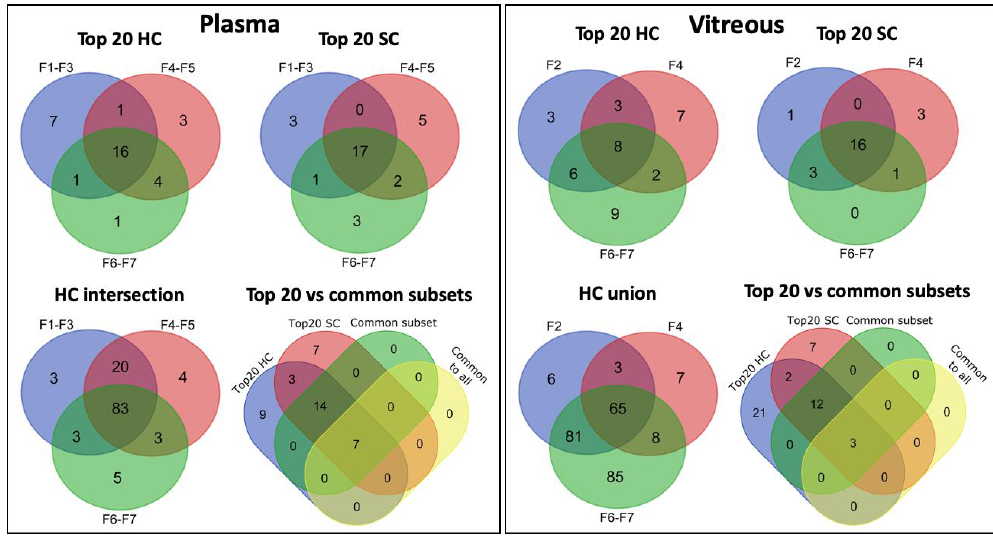
Figure 9. Venn diagrams of the commonalities between the neutral 100 nm (F1–F3 or F2), anionic 100 nm HA-coated (F4–F5 or F4), and anionic 50 nm (F6–F7) groups. Plasma: the top 20 most abundant proteins in the plasma HC (Top 20 HC) and SC (Top 20 SC), and their comparison with the common subsets (Top 20 vs common subsets), and for all HC proteins in found in plasma samples (HC intersection). Vitreous: the top 20 most abundant proteins in the vitreous HC (Top 20 HC) and SC (Top 20 SC), and their comparison with the common subsets (Top 20 vs common subsets), and for all HC proteins in found in vitreous samples (HC union).